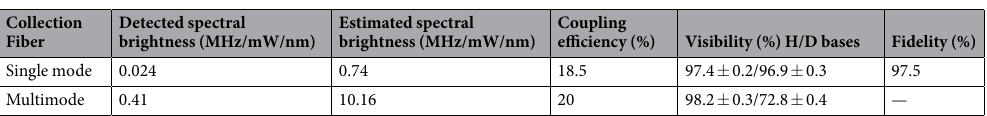
Table 2. Performance parameters of the SPDC source measured using both single mode and multimode fibers at the crystal temperature of 29